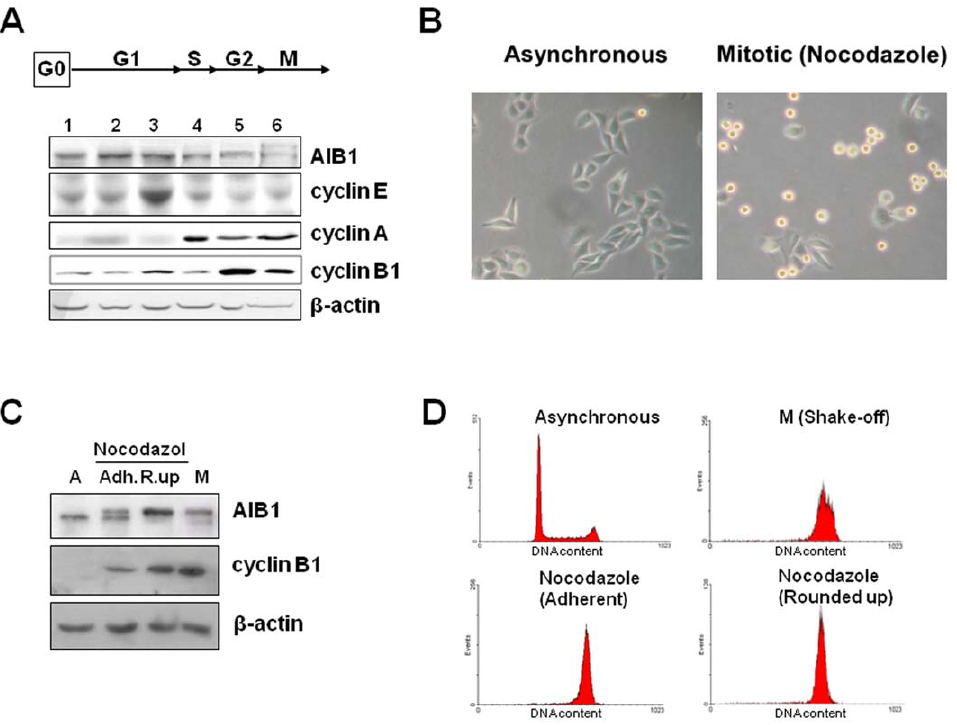
Figure 1. Post-translational modification of AIB1 occurs at the entry to mitosis. (A) Western blot analysis of HeLa cells arrested at the different stages of the cell-cycle as indicated in the scheme. Anti-AIB1 antibodies reveal an electrophoretic mobility shift in mitotic cells (lane 6). Antibodies against indicated cyclins were used to confirm cell-cycle progression through the different stages. b -actin was used as loading control. Chemically-induced cell cycle arrest was produced using the following drugs at the doses and times described in materials and methods: lane 1: cyclosporin A; lane 2: wortmannin; lane 3: L-mimosine; lane 4: hydroxyurea; lane 5: etoposide, and lane 6: nocodazole. (B) Morphology of asynchronous culture of HeLa cells and cells treated with nocodazole to arrest them at the beginning of mitosis. Rounded up cells (light refracting) are cells that have entered mitosis. The increased number of rounded uping cells under nocodazole treatment visually confirms the enriched mitotic population. (C) Western blot analysis of asynchronous growing cells (A), nocodazole-treated cells and mitotic cells (M) isolated from an asynchronous culture by shake-off. Nocodazole-treated cells were divided into rounded up cells (R.up) and those that still remained attached (Adh.) to the surface of the culture dish. (D) Flow cytometry analysis was used to confirm the DNA content of cells treated as indicated in